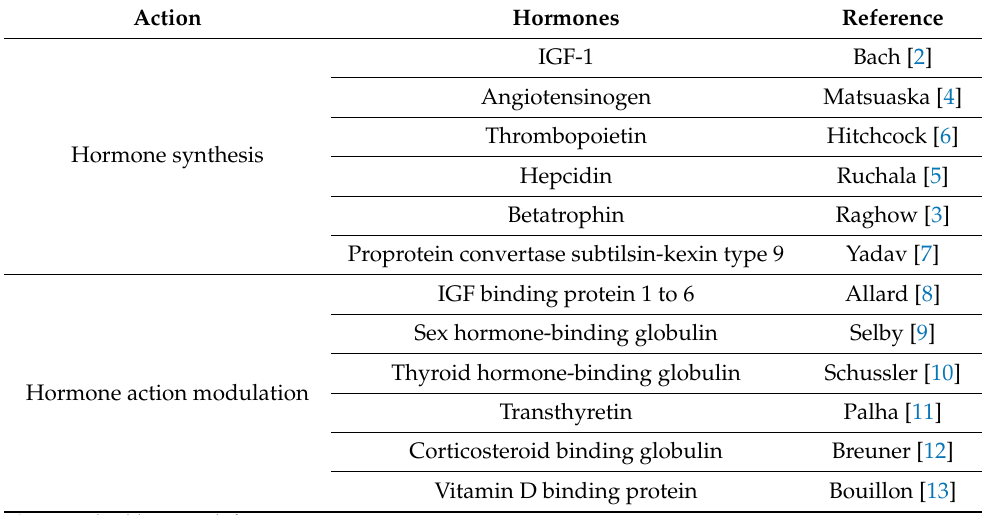
Table 1. The liver as an endocrine